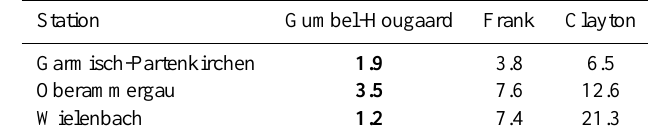
11 Table 6: Value of the K-function times 10 4 for radar/gauge pairs at the stations Garmisch-Partenkirchen, Oberammergau and Wielenbach for three Archimedean Copulas (Gumbel-Hougaard, Frank, Clayton). Smallest values indicate the best fit (bold).